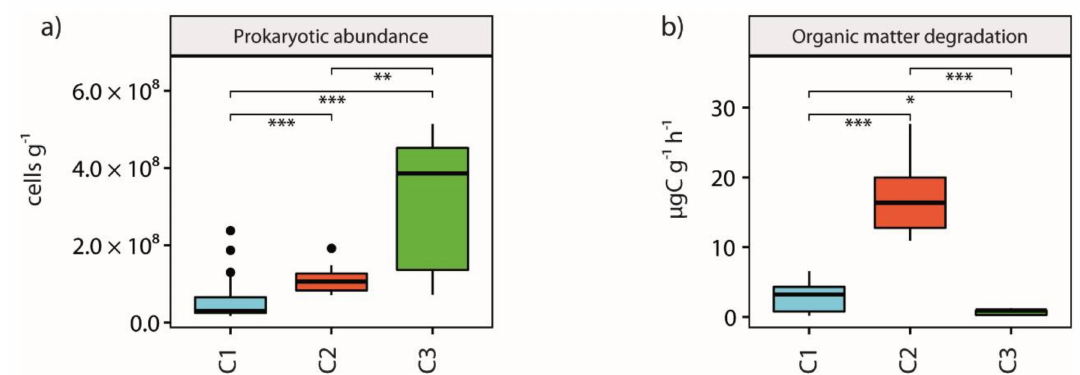
Figure 2. Impact of acidification on prokaryotic abundance and dynamics. Histograms showing the average values for prokaryotic abundances ( a ) and organic carbon degradation rates ( b ) among the 3 clusters identified, with asterisks displaying significant differences between clusters (* for p -values < 0.05, ** for p -values < 0.01, *** for p -values < 0.001) and error bars computed on the standard error for each